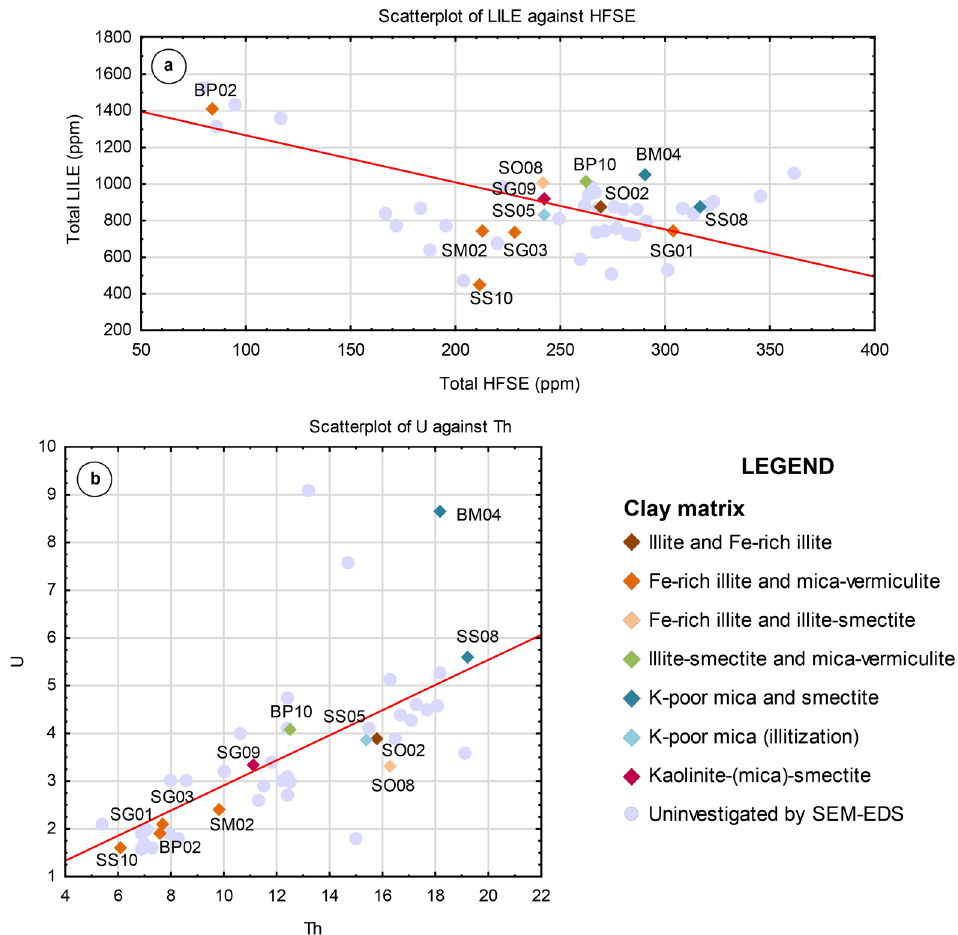
Figure 9: Bivariate plots comparing selected trace elements: ( a ) LILE versus HFSE and ( b ) Th versus